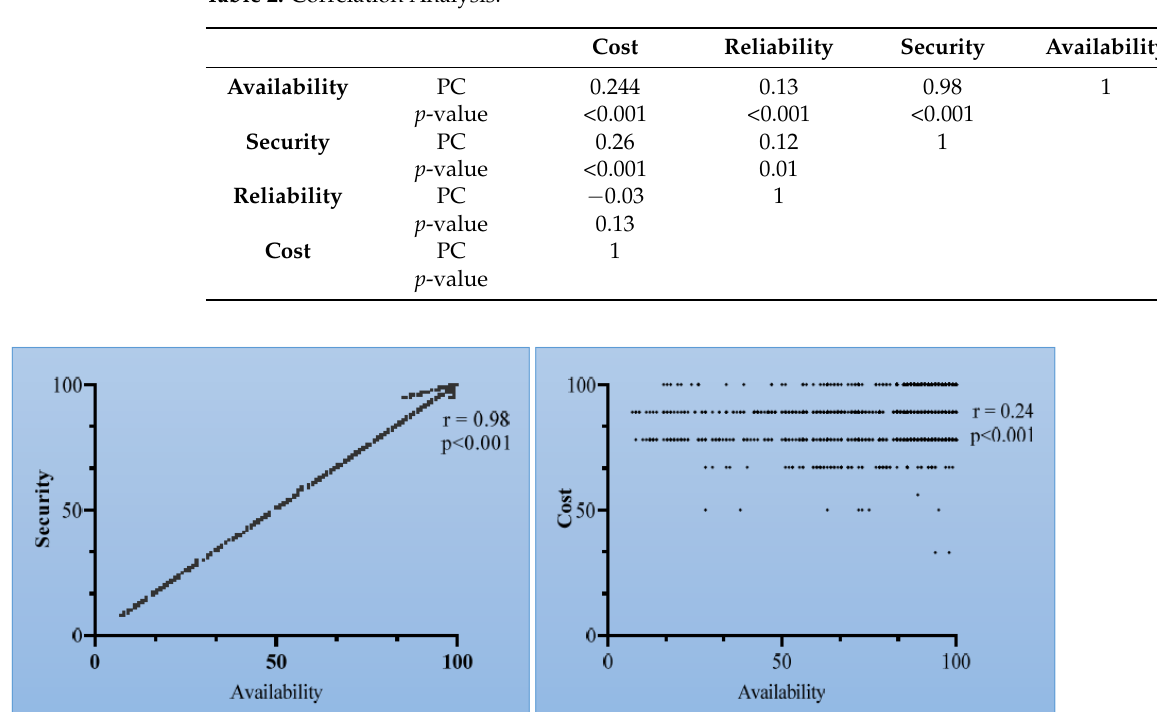
Figure 6. Cloud-service ranking for identified parameters using Student’s t -test. Table 2. Correlation Analysis.